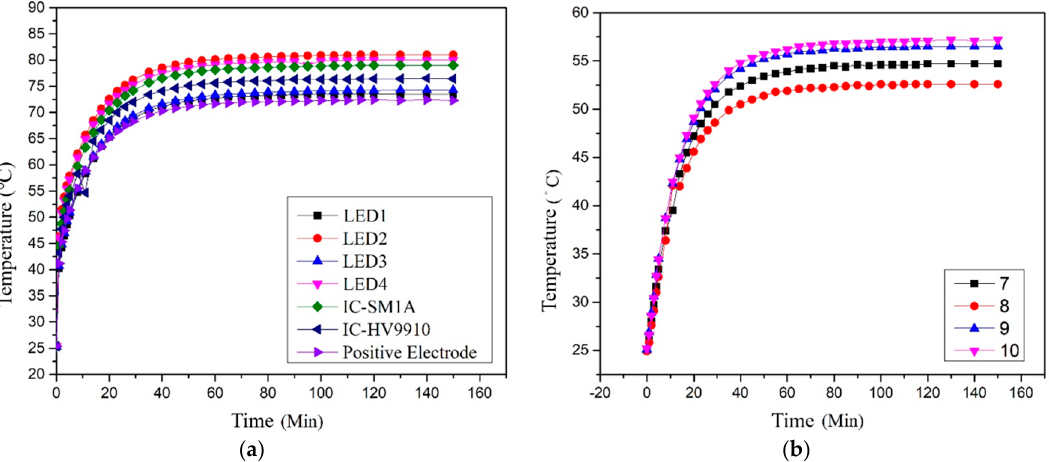
Figure 6. Temperature measurement of 60 V/0.15 A LED. ( a ) LED internal temperature field. ( b ) Aluminum fin temperature field.